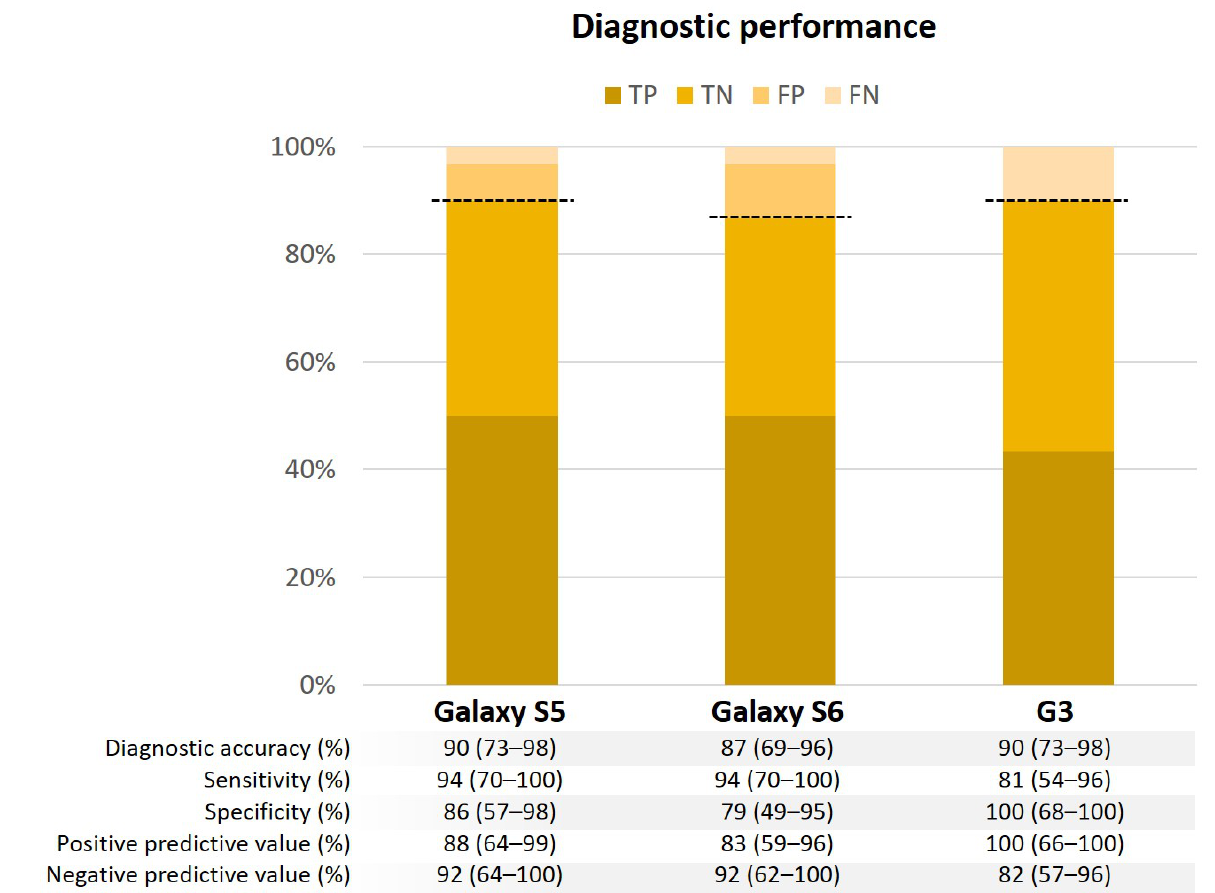
Figure 2. Diagnostic performance of each study device. Bold broken lines indicate diagnostic accuracy. FN: false negative; FP: false positive; TN: true negative; TP: true